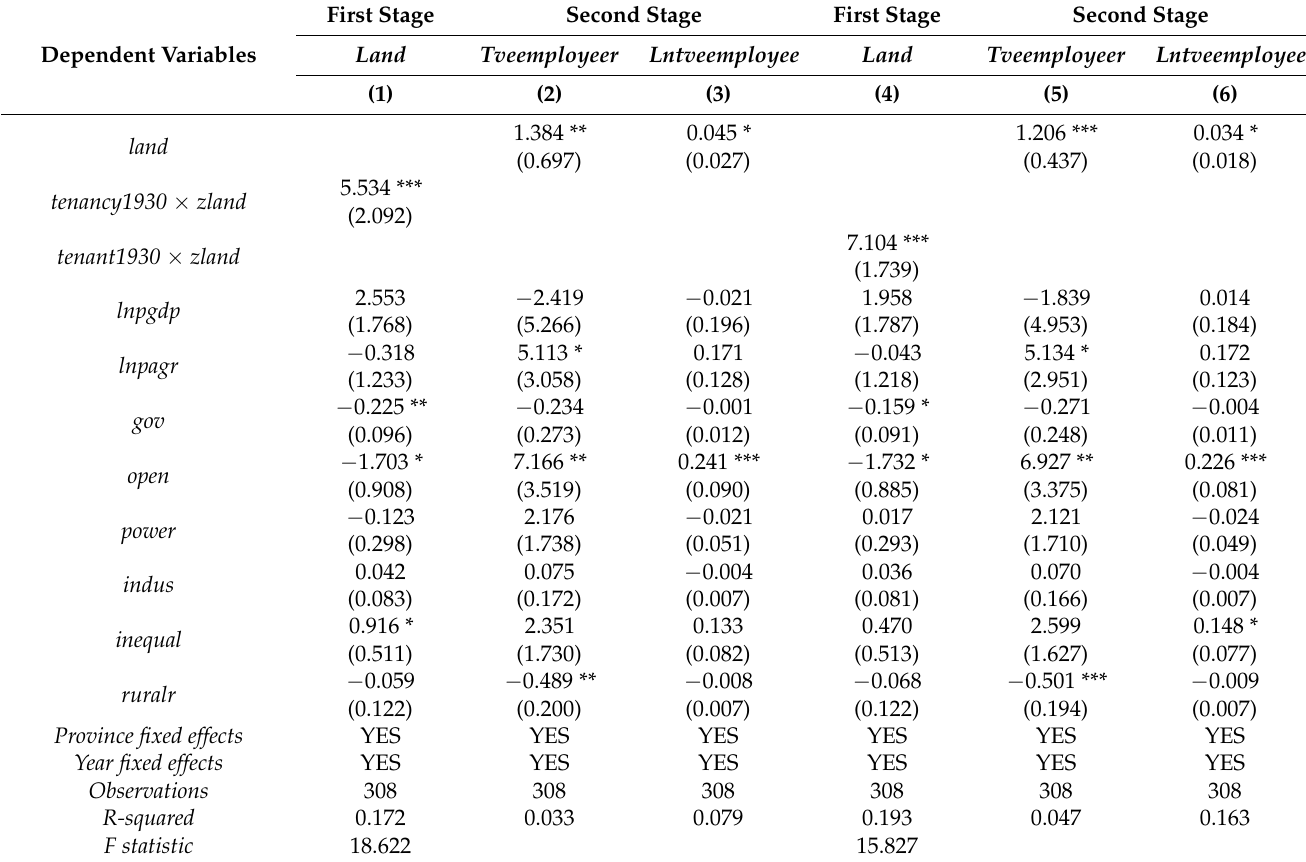
Table 4. The transfer of rural collective construction land and the rise of TVEs: IV